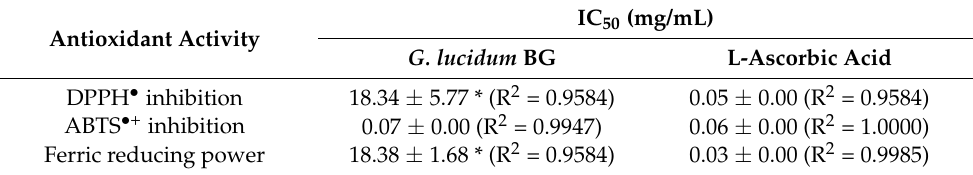
Table 2. Antioxidant activities of antler-type G. lucidum BG.